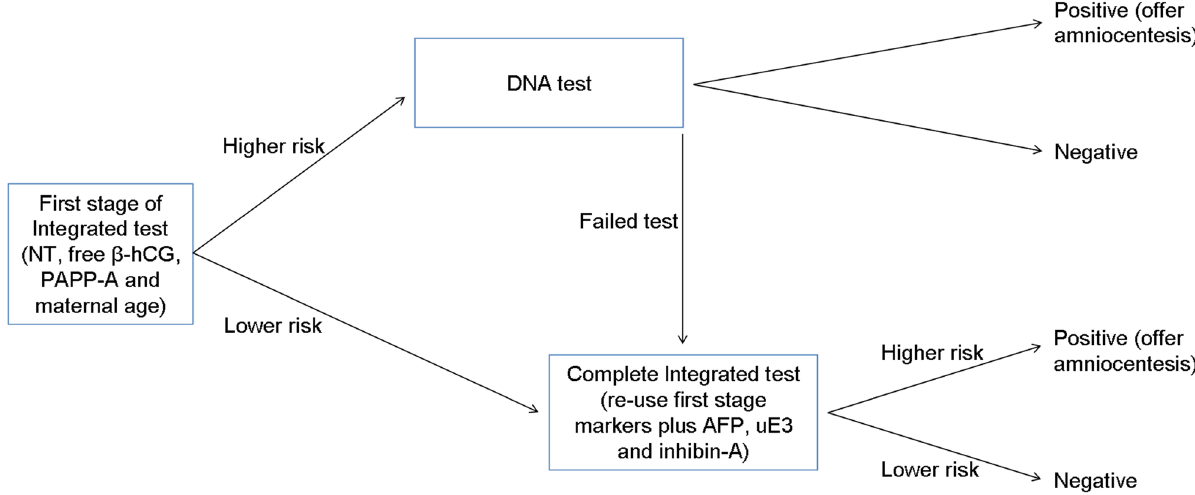
Figure 1. Protocol for reflex DNA testing in conjunction with Integrated test screening.